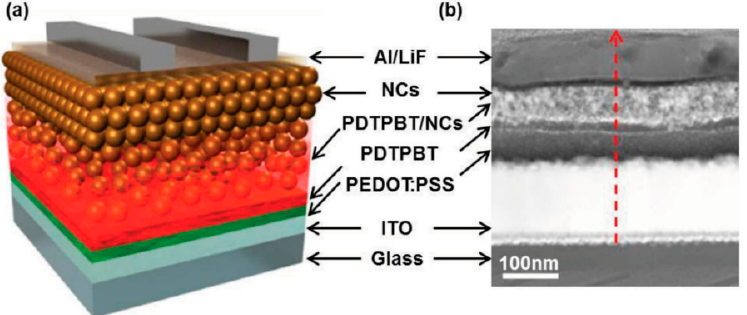
Figure 18. ( a ) Schematic illustration of a hybrid solar cell with a vertical D-D:A-A structure in the active layer of the device. The self-assembled vertical phase separation occurs in the polymer/QD blend film during spin-coating. Then pure NC layers are deposited on top of the blend. Reprinted with permission from John Wiley and Sons: Advanced Materials Ref. [30], Copyright 2013.